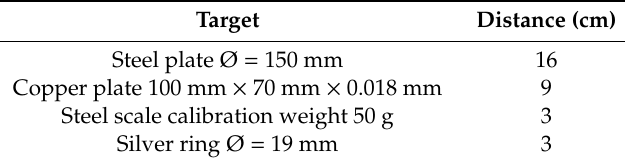
Table 1. Detection ranges of various targets located on the central axis of the coil.